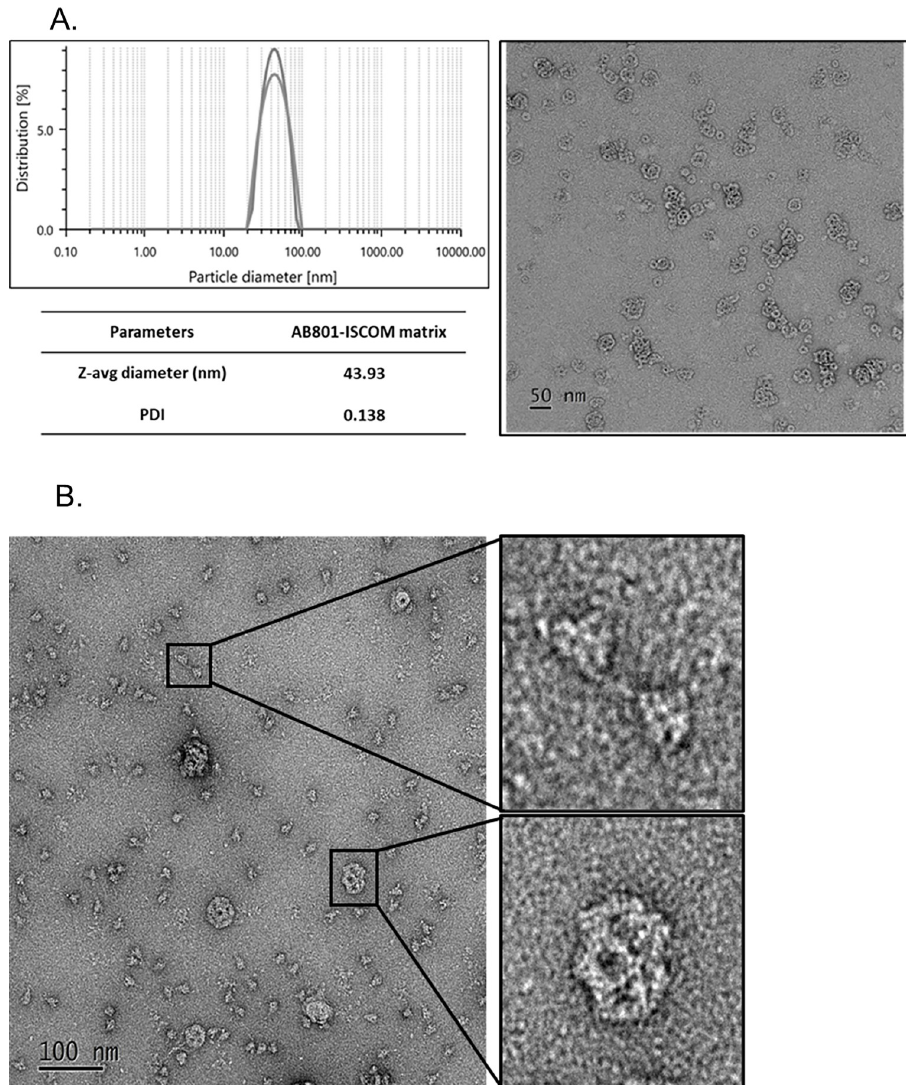
Fig 2. Characterization of AB801-ISCOM with dynamic light scattering (DLS) and transmission electron microscopy (TEM)s. (A) Dynamic light scattering (DLS) analysis of AB801-ISCOM. Duplicate analysis was performed to demonstrate the consistency. (B) Transmission electron microscopy (TEM) Image of AB801-ISCOM. (C) The negative stain EM structural analysis of BCVax, consisting of delta S protein and AB801-ISCOM. The EM image showed delta S protein in trimer structure with homogenous distribution. The size of delta S protein and AB801-ISCOM is about 20 nm and 40 nm, respectively. The upper right image shows magnified delta S protein trimer. The lower right image shows magnified AB801-ISCOM in cage like